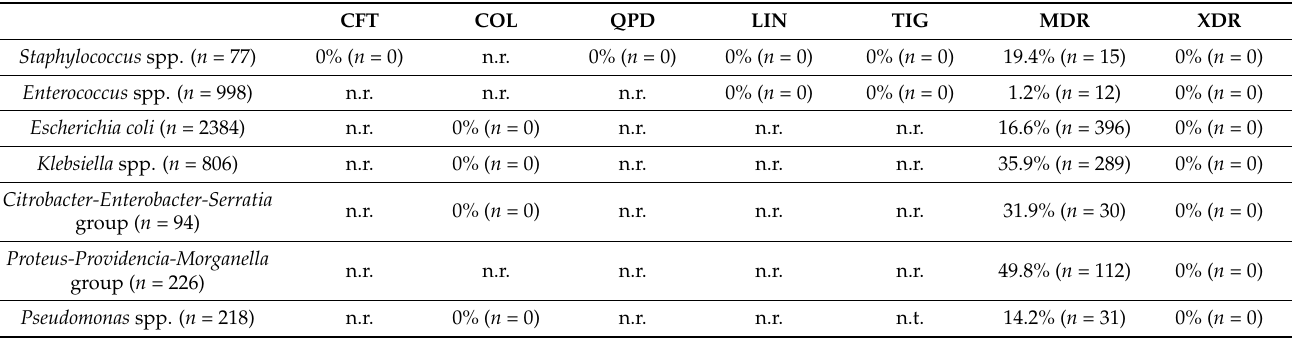
Table 8. Percentage of resistant isolates from outpatient UTIs against WHO Reserve antibiotics and rates of MDR and XDR isolates.